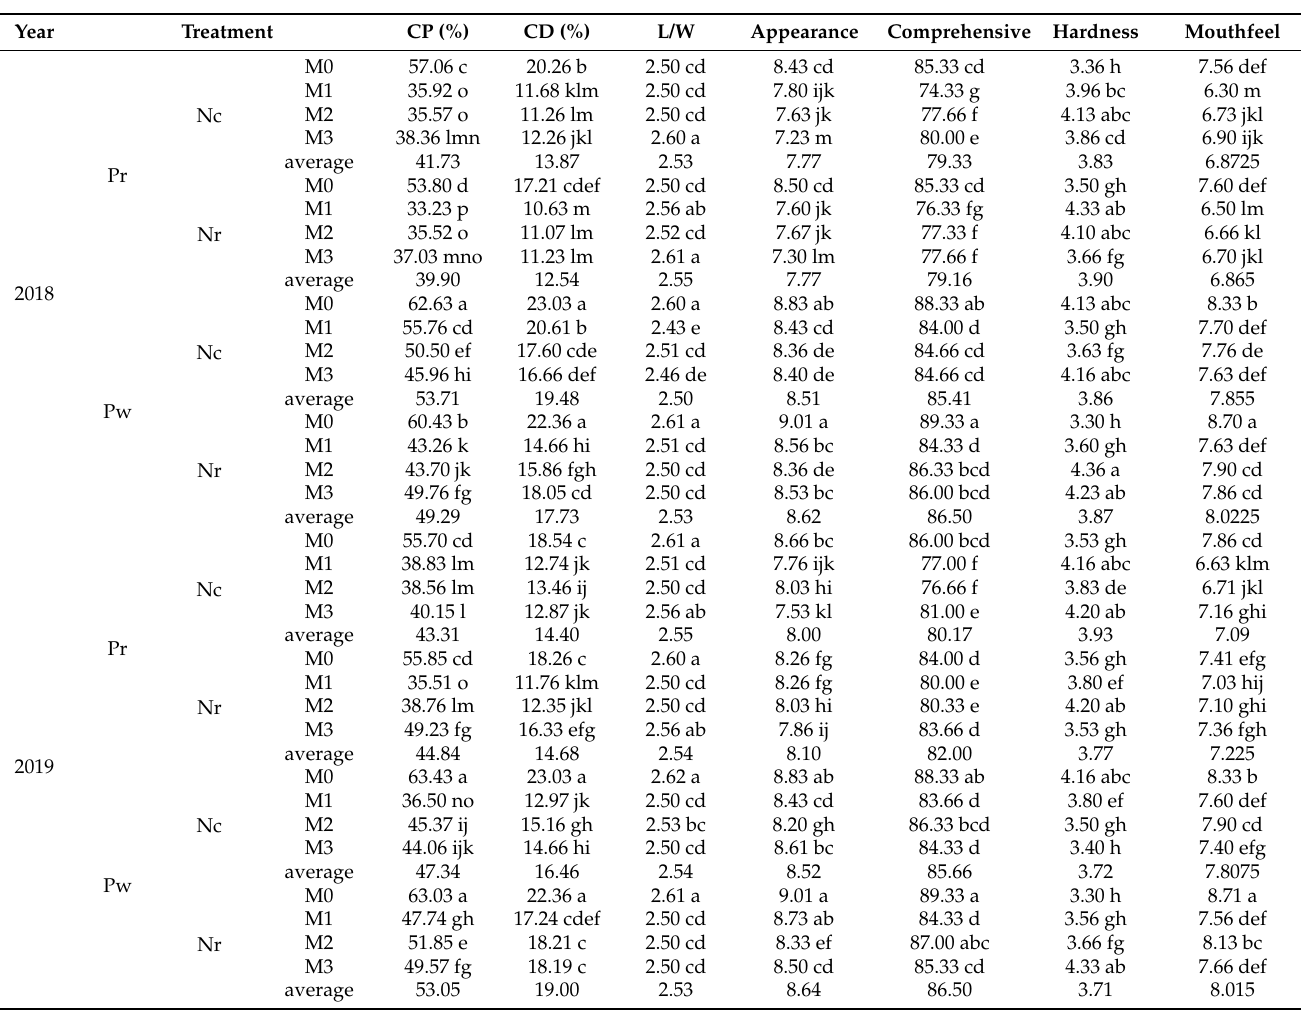
Table 4. The effects of the N application rate in the previous season and N management in the rice season on rice appearance quality and eating quality.